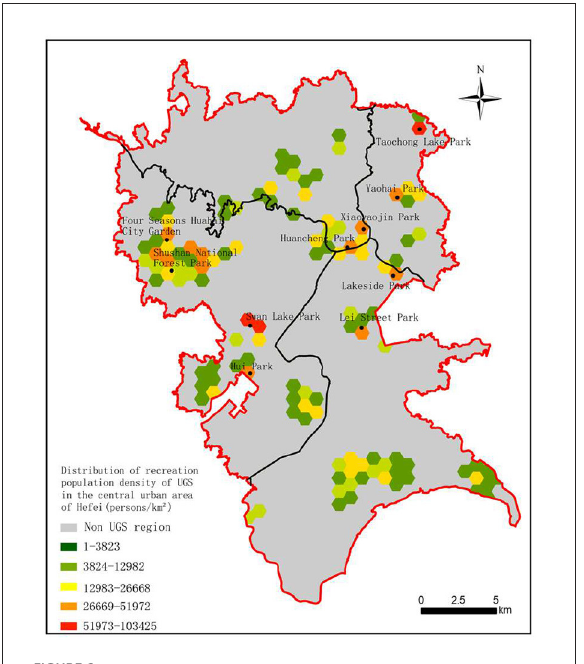
FIGURE6 Distribution of the UGS recreational population density in the central urban area of Hefei.